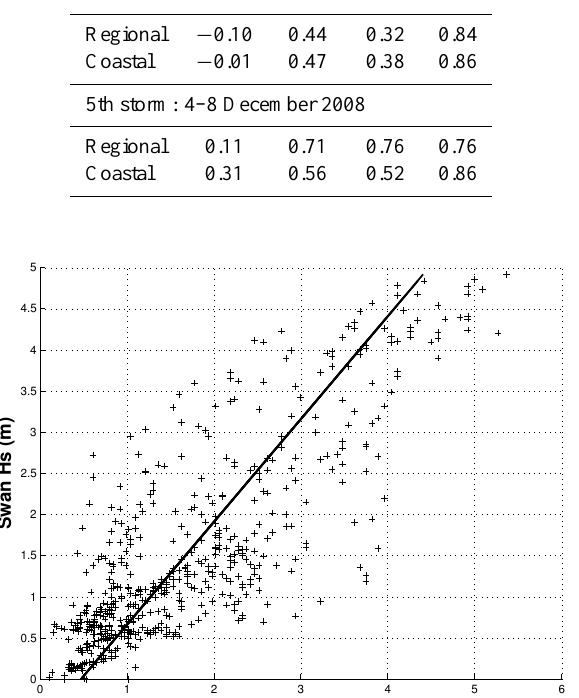
Fig. 5. Scatter diagram of buoy recorded vs. SWAN T p . The storm events considered in the analysis are listed in Tab.1